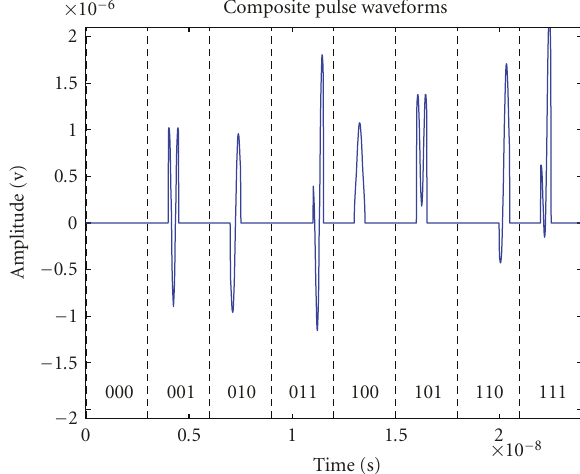
Figure 1: Composite MHPs for a 3-bit OOK-PSM modulation